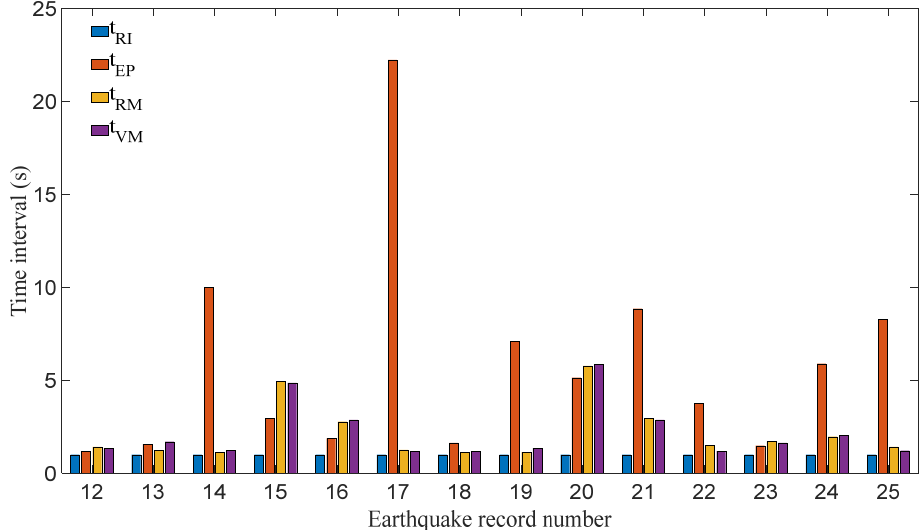
Figure 10. Unified key time points in the case of near-field earthquakes.